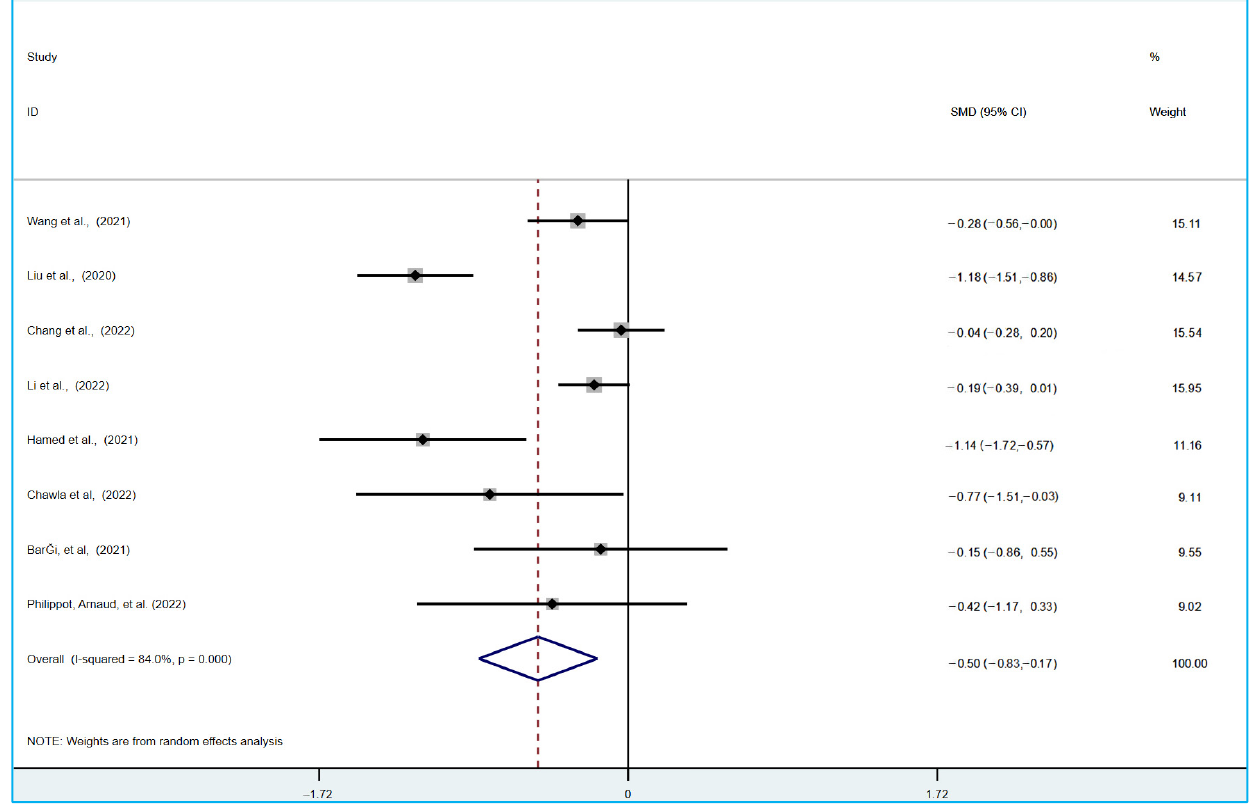
Figure 3. The Influence of Physical Activity on University Students’ Anxiety Disorder [58–65].